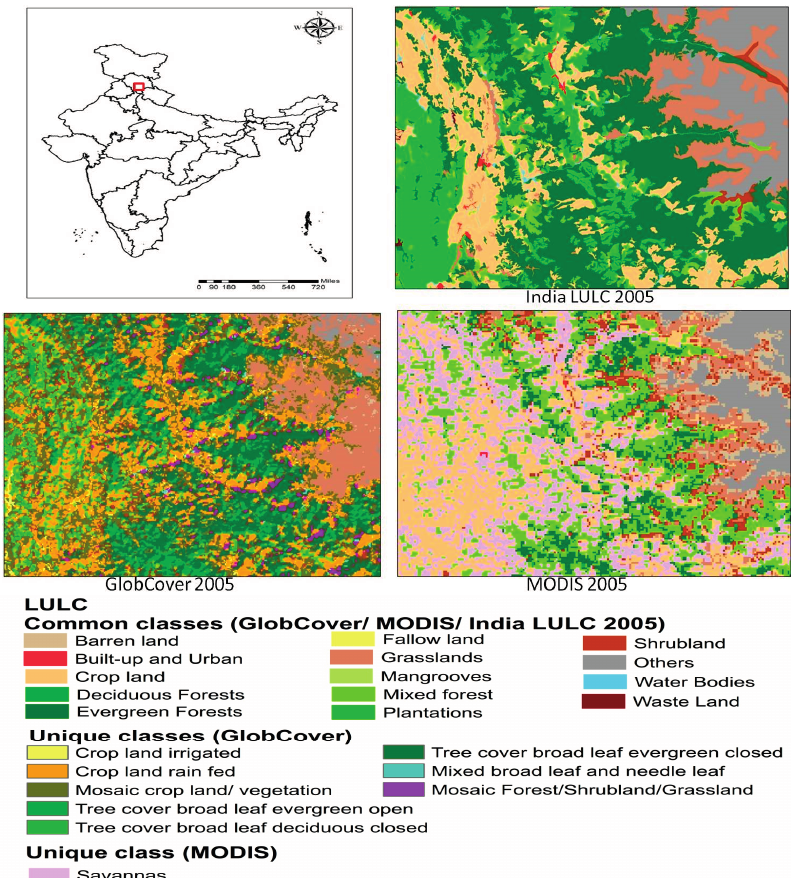
Figure 11. Comparison of resolution of LULC 2005 India product with MODIS Land Product and